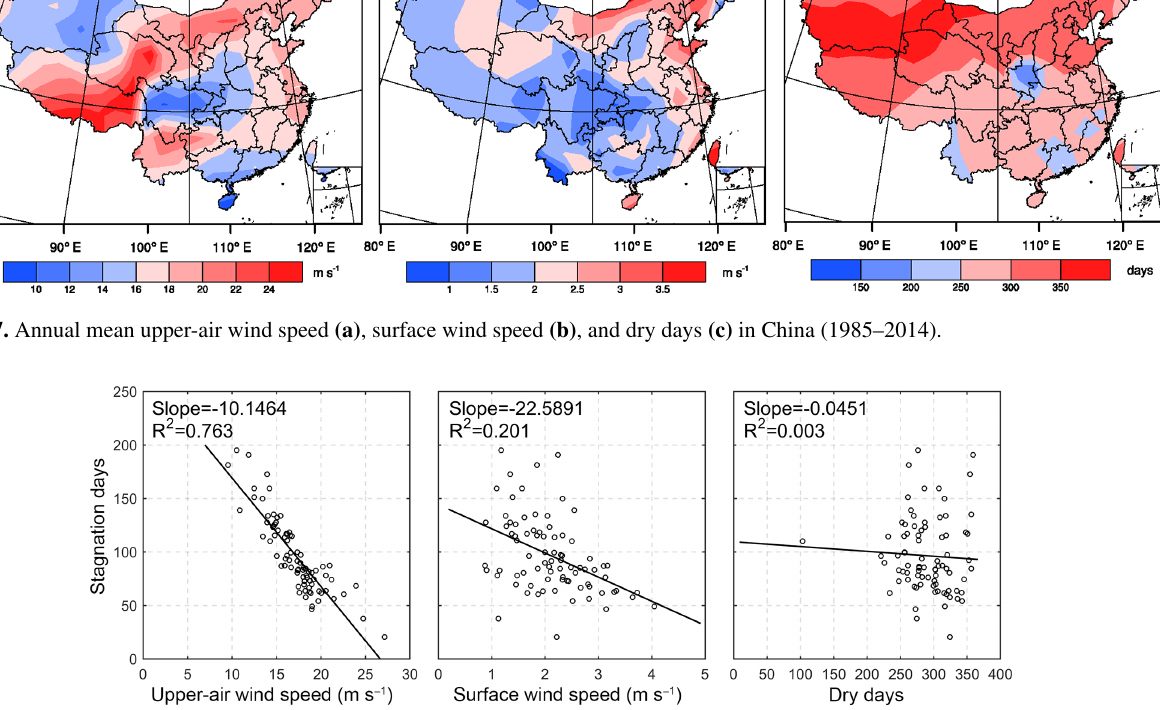
Figure 8. Dependence of the spatial distribution of stagnation days on three components (upper-air wind speed, surface wind speed, and dry days). Linear regression coefficients between annual mean stagnation days at 81 stations and each corresponding component are